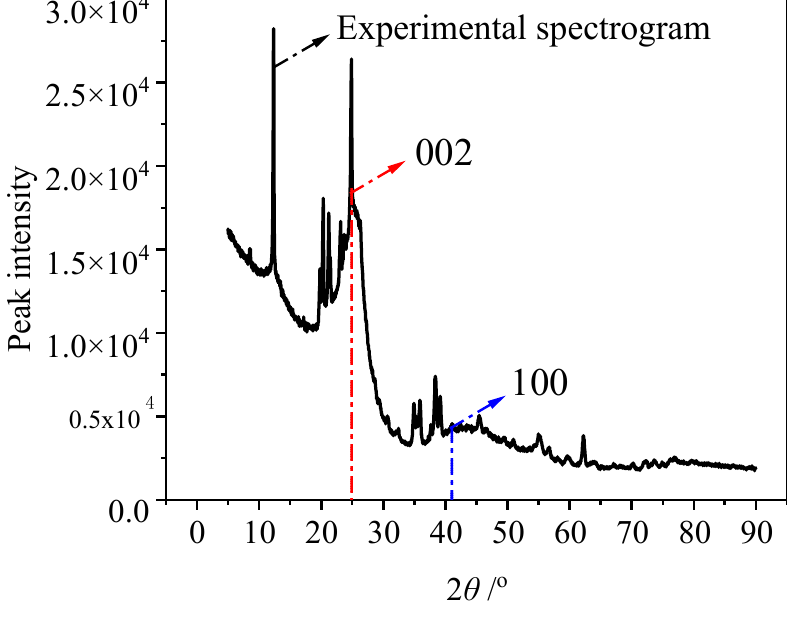
Figure 3. XRD spectrum of gas coal.